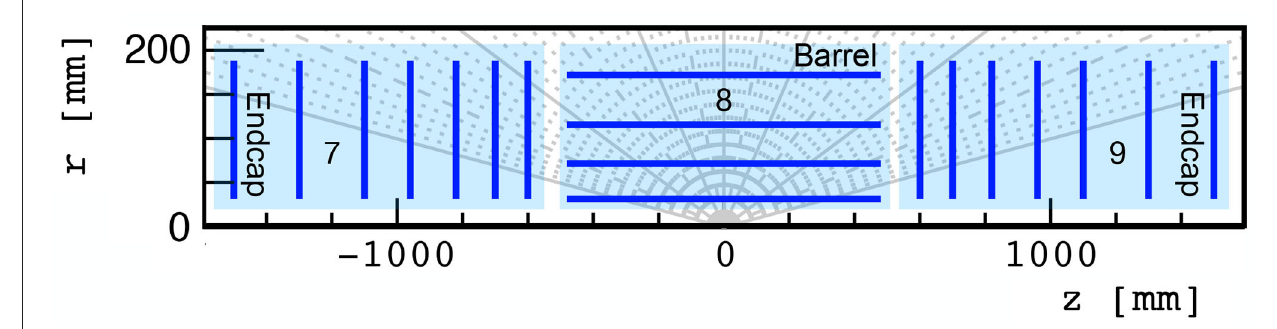
FIGURE 1 | TrackML pixel detector regions labeled 7, 8, and 9, used in this study, consisting of 7, 4, and 7 layers, respectively.